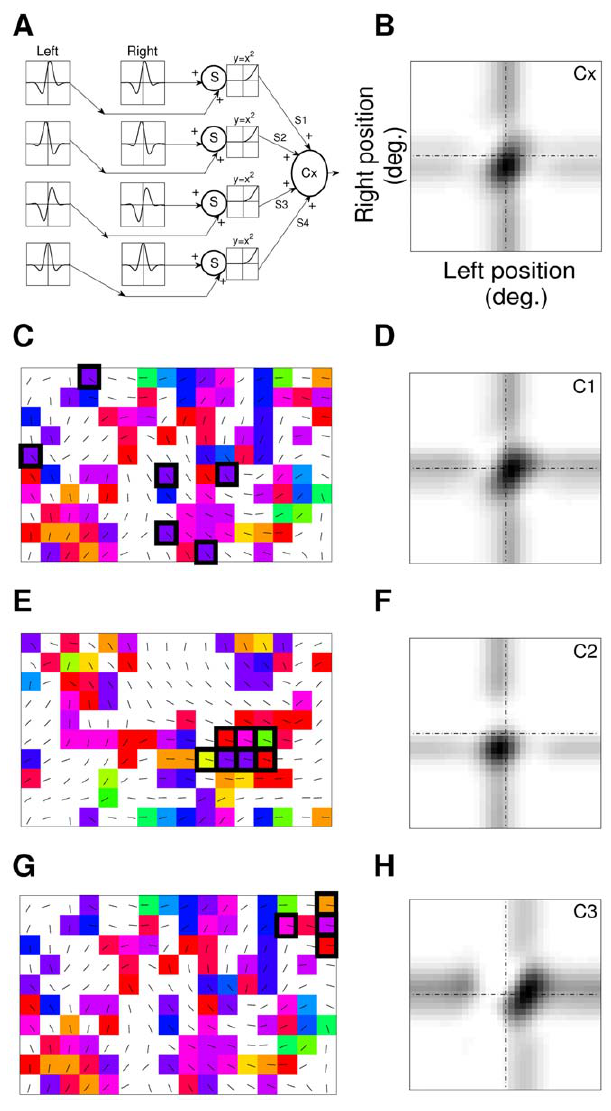
Figure 9. Complex cells. (A) Complex cell Cx built using four linear filters with spatial phases of 2 45 u , 45 u , 2 90 u and 0 u . (B) Binocular RF of complex cell Cx. (C) Complex cell C1 built using simple cell subunits with almost same disparity selectivity. The simple cell subunits are marked with black rectangular outlines in DP map patch. (D) Binocular RF of complex cell C1. (E) Complex cell C2 built using simple cell sub- units exhibiting a systematic change in disparity selectivity. Subunits are marked with black rectangular outlines. (F) Binocular RF of complex cell C2. (G) Complex cell C3 built using simple cell subunits exhibiting a systematic change in disparity selectivity. Subunits are marked with black rectangular outlines. (H) Binocular RF of complex cell C3.